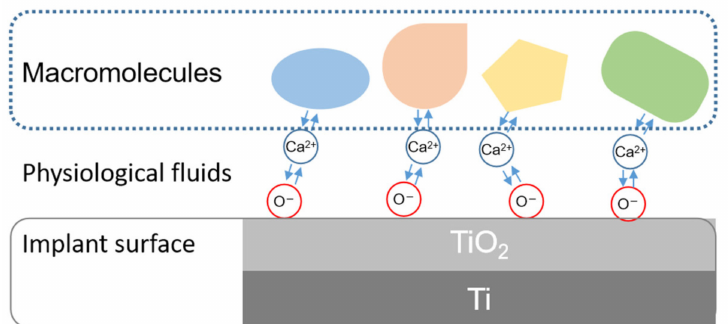
Figure 2. Possible mechanism for the initial adsorption of macromolecules on Ti implants. TiO 2 has an overall negative charge at the interface with the physiological fluids. Ca attracts on the surface, and further, it binds to the macromolecules on the surface of the